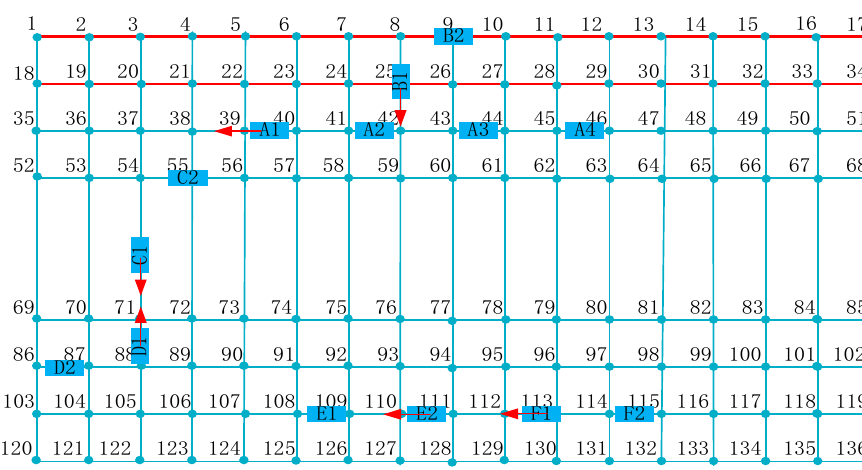
Figure 5. Conflict situation of IGV